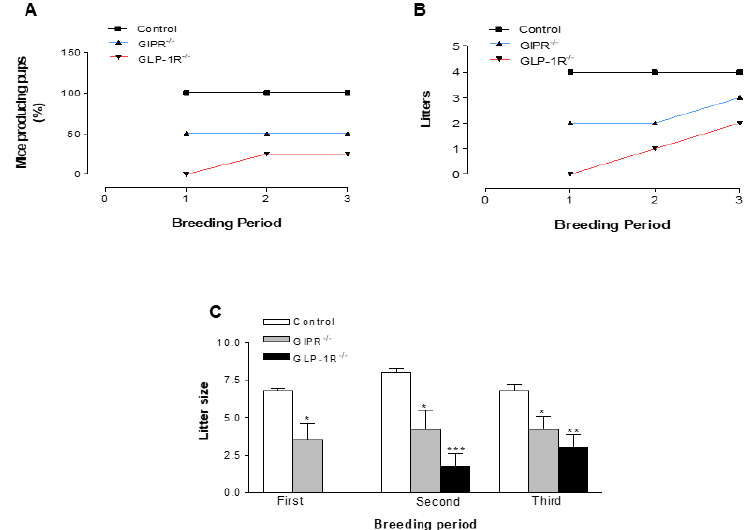
Figure 4. Percentage of animals producing pups, litters and litter size in WT, GIPR −/− and GLP-1R −/− mice. Female (WT, GIPR −/− or GLP-1R −/− ) mice ( n = 4) were bred with age-matched normal male C57BL/6J mice over three breeding periods of 20 days each. ( A ) Percentage of mice producing pups, ( B ) litters produced and ( C ) average litter size in female WT, GIPR −/− and GLP-1R −/− mice. Litter size corresponds to number of pups in each litter whilst litter refers to number of litters produced. Values are mean ± SEM with n = 4. * p < 0.05, ** p < 0.01, *** p < 0.001 compared to control.